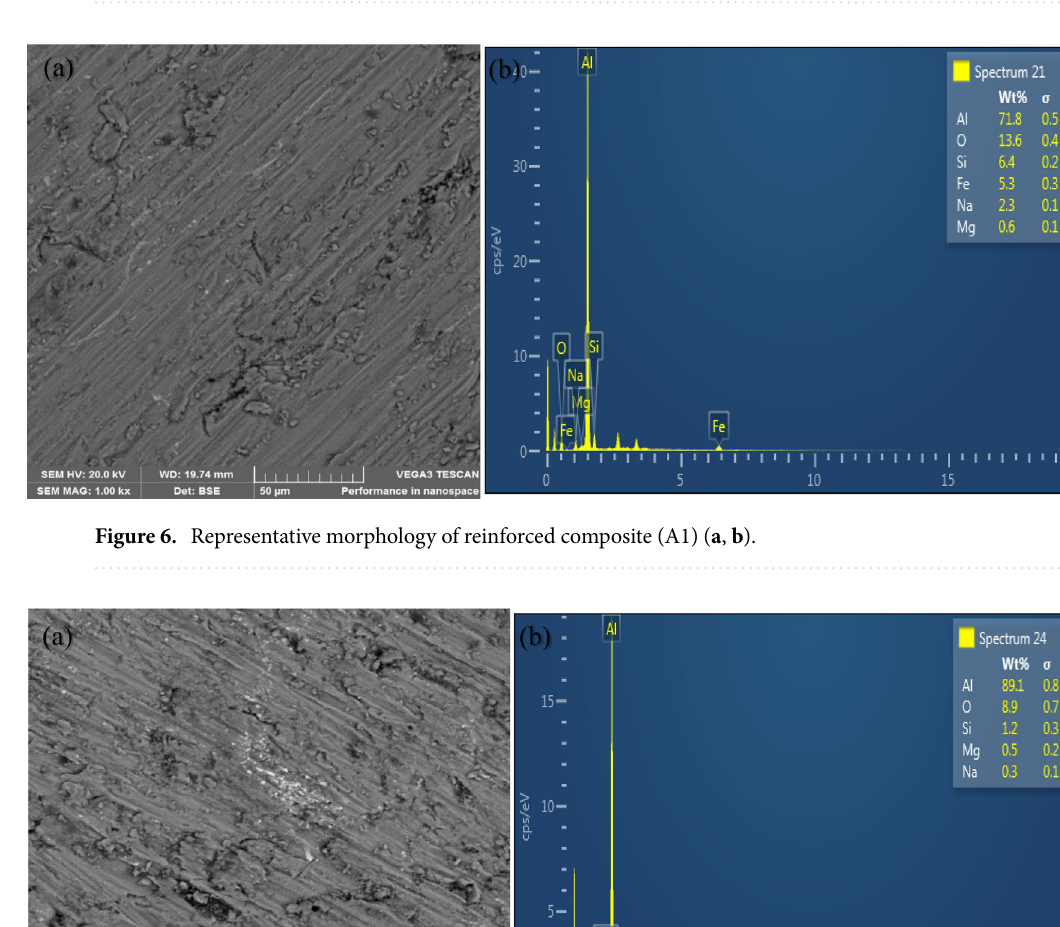
Figure 5. ( a ) Scanning electron micrograph and ( b ) EDS spectrum of Al6063.